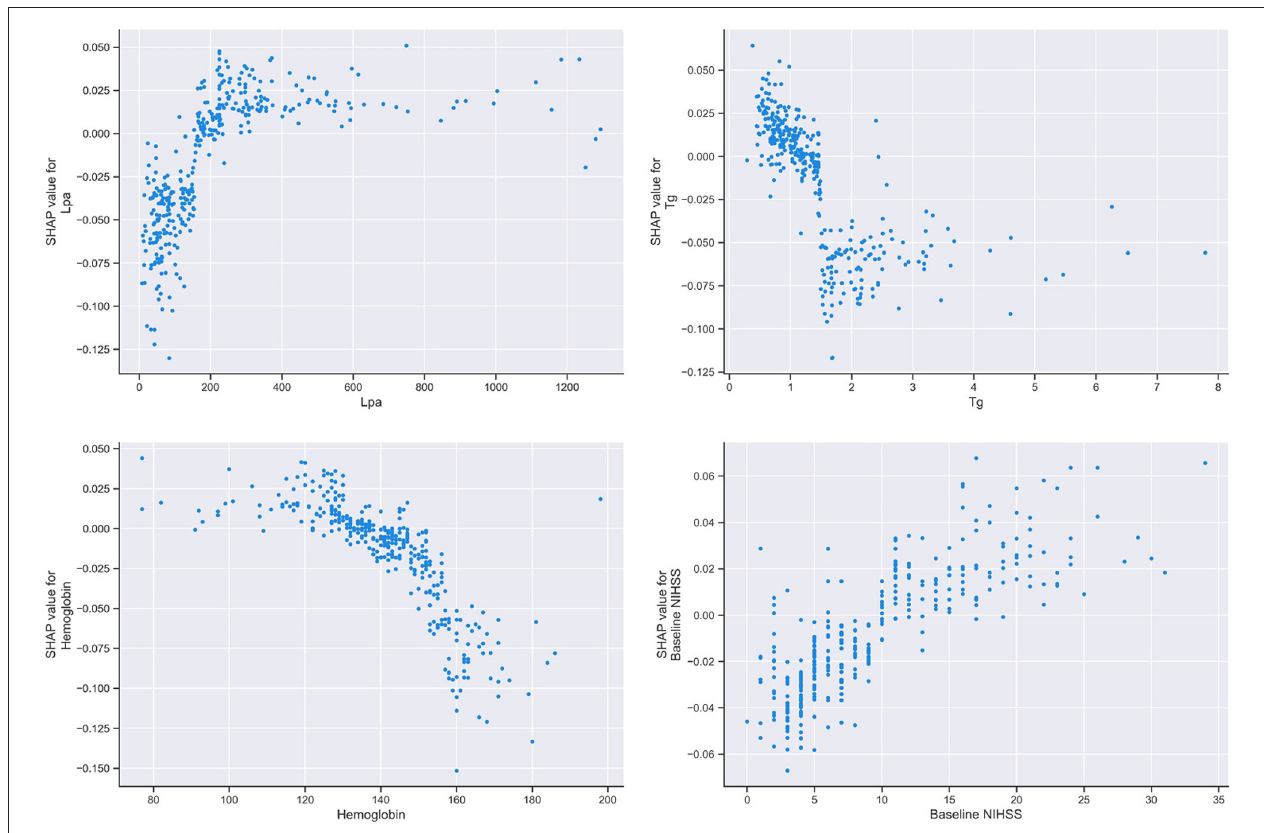
FIGURE 6 | SHAP dependence plot of the RF model. The SHAP dependence plot shows how a single feature affects the output of the RF prediction model. SHAP values for specific features exceed zero, representing an increased risk of HT after IVT. SHAP, SHapley Additive exPlanation; RF, random forest; HT, hemorrhage transformation; IVT, intravenous thrombolysis; Tg, triglycerides; Lpa,